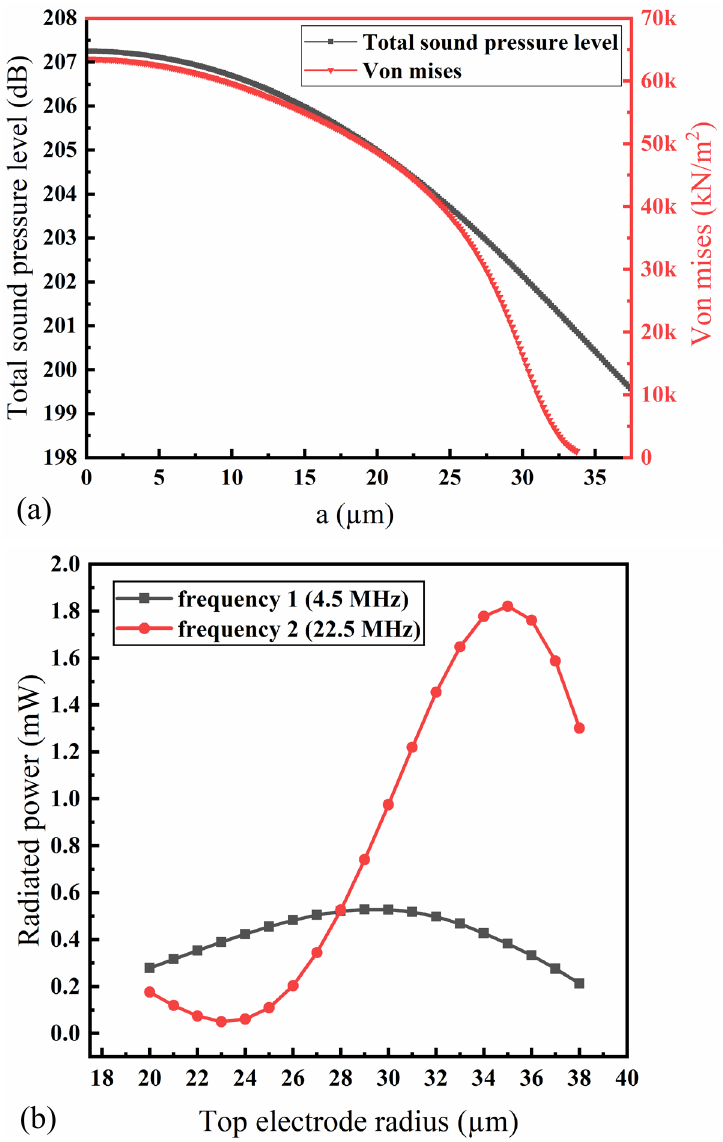
Figure 8. ( a ) SPL and stress distributions at the acoustic–structure interface; ( b ) variation curve of the radiated power with radius at two different frequencies.